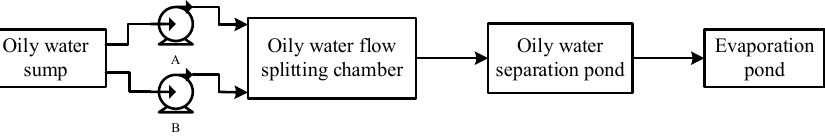
Fig. 1. Process flow of oily water drainage